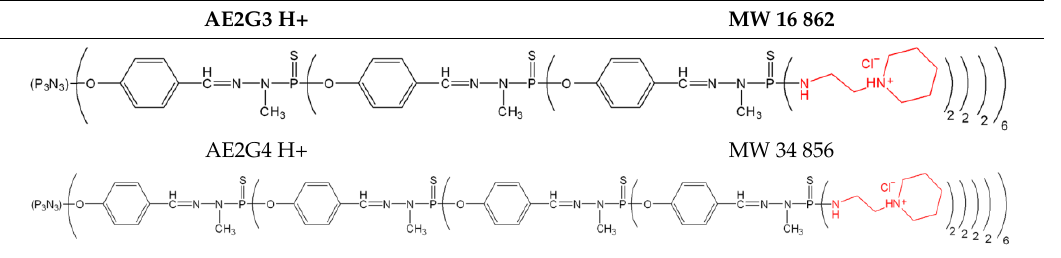
Table 2. Structures of the cationic phosphorous dendrimers.